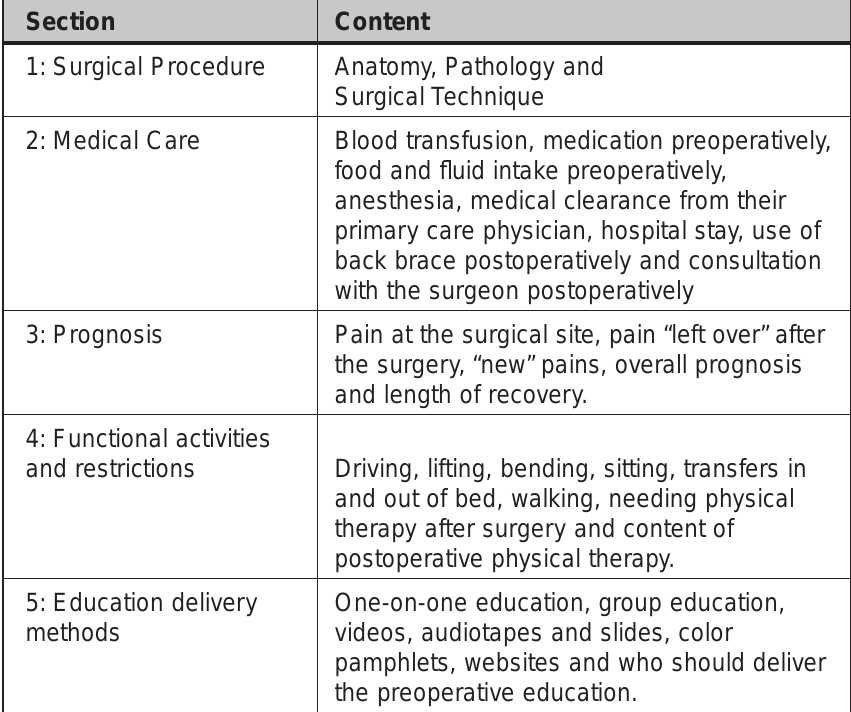
Table 1: Surgery Questionnaire